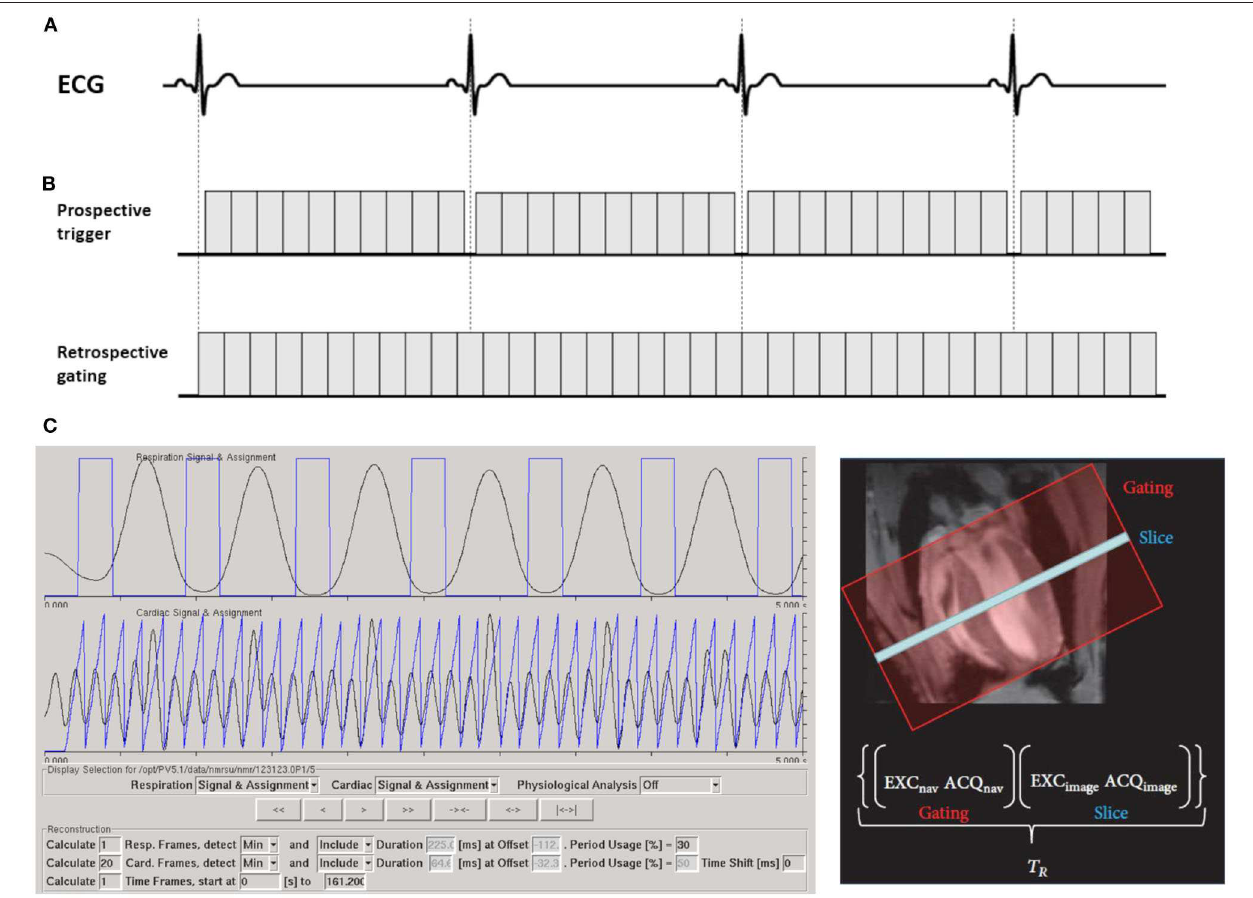
FIGURE 1 | Strategies for the synchronization of cardiac cine MRI with the cardiac cycle. (A) In the prospective triggering scheme, the acquisition is synchronized with the ECG signal. After detecting the R wave, a suitable trigger delay is set due to application, then cardiac acquisitions can be performed at a specific phase of the heartbeat or to acquire multiple consecutive cardiac phases of the cardiac cycle. (B) In the retrospective gating scheme, data are acquired continuously while simultaneously recording the ECG and respiratory signals. (C) As an alternative, an additional navigator signal is acquired prior to each echo. Primary signals are calculated from navigator scans. The navigator signals are automatically analyzed and weighted according to their contribution to respiration and cardiac signals. The weighted physiological signals are retrieved (with demerging) and/or frequency filtered (with Fourier Filter) to create respiration and cardiac signal, which are used to assign each echo to its correct position in the cardiac and respiratory cycles. Retrospective gating signal is acquired with ParaVision 5.1 (IntraGate © , Bruker Biospin, Ettlingen, Germany). The partial figure is reproduced with permission from Zuo et al.